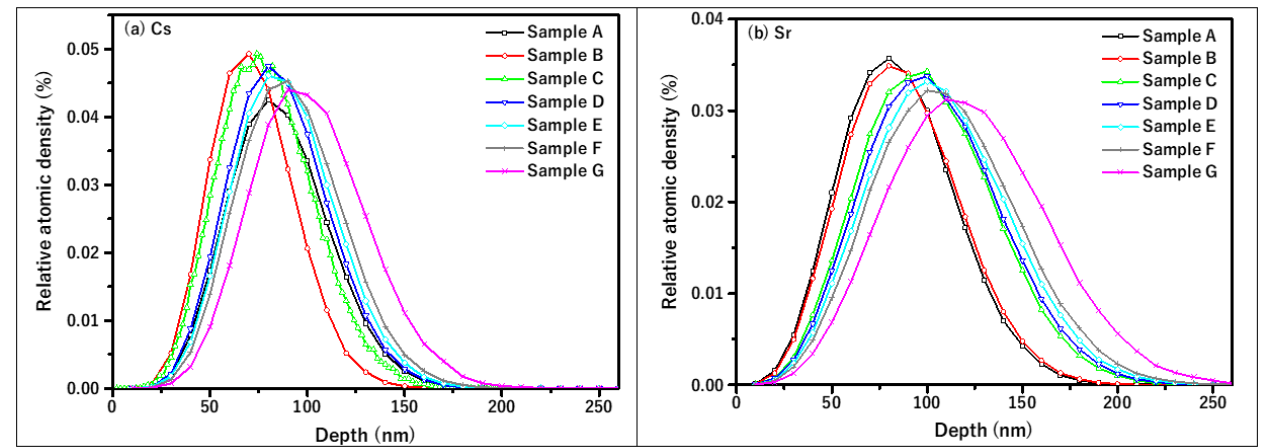
Table 1. Simulation result of the four moments of Cs and Sr ions distribution in different clay samples.